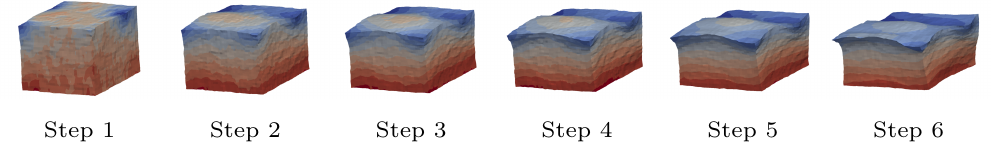
Figure 5. Magnitude of the experimental displacements at the pre-peak steps (deformed